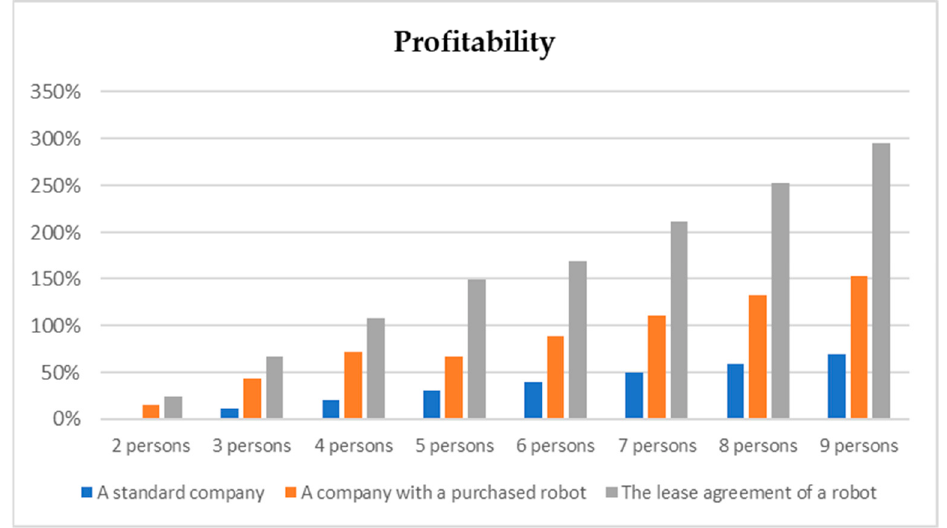
Figure 4. Profitability of the business in three varieties for businesses employing between 2 and 9 people. The taxes do not take account of the tax on robotification.